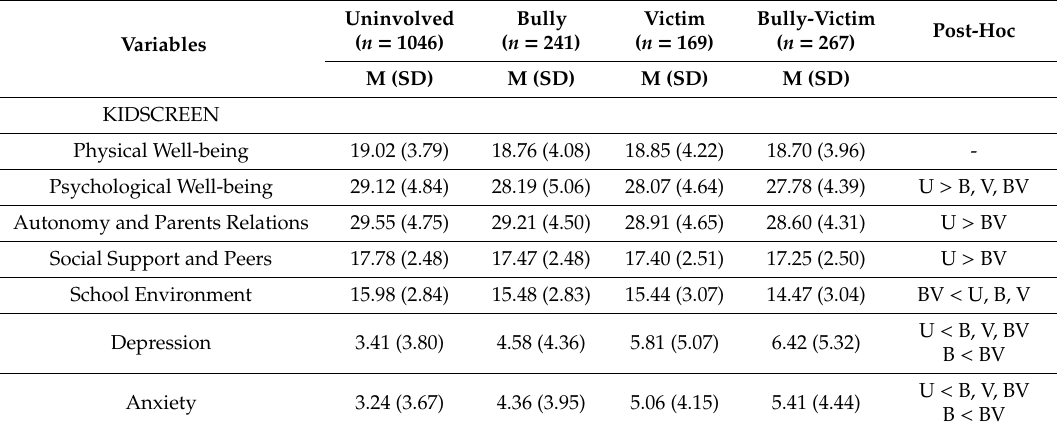
Table 4. Means and Standard Deviations in HRQoL Dimensions, Depression and Anxiety for Each Homophobic Verbal Content Bullying